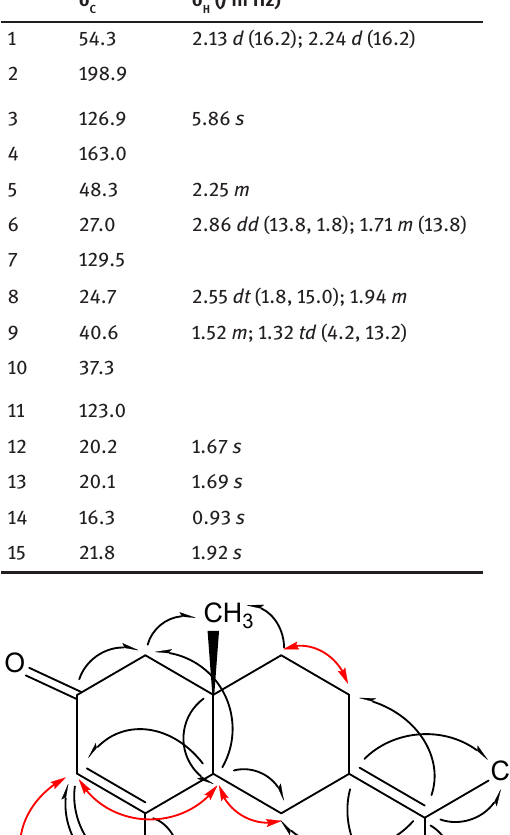
Table 5: 1 H (600 MHz) and 13 C (150 MHz) NMR assignments of 1 in CDCl δ C